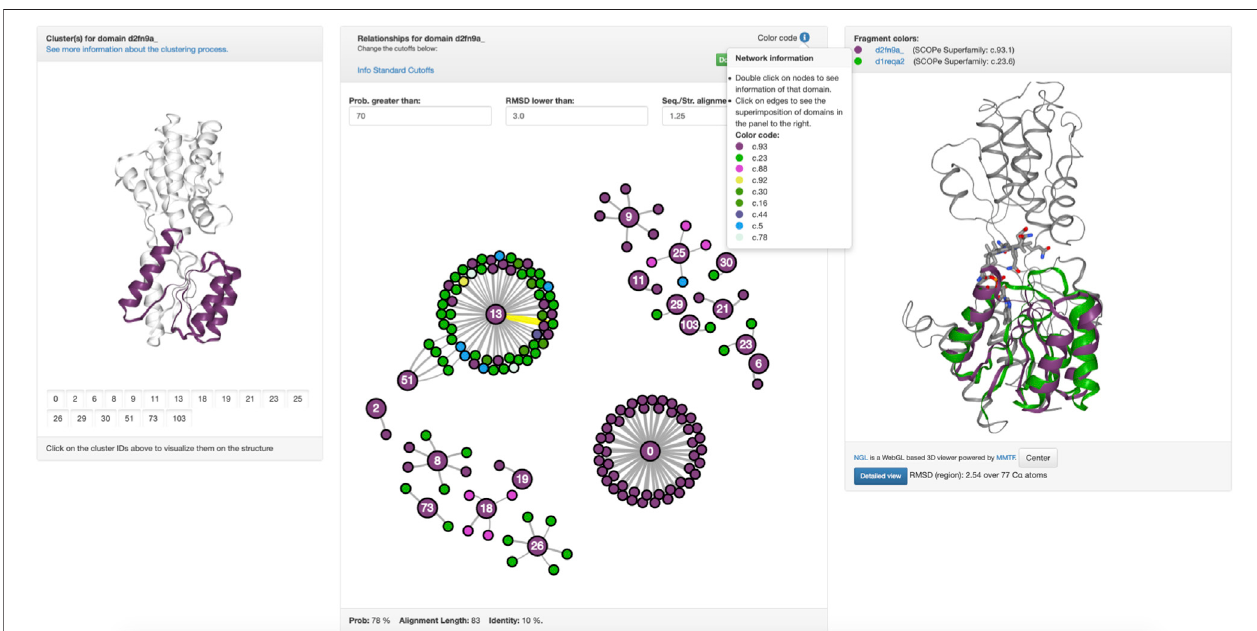
FIGURE 2 | Conservation in tmRBP. (c.f. https://fuzzle.uni-bayreuth.de/2.0/hh/fragment_graph/d2fn9a_/). Left: The panel highlights each hit in d2fn9a_. In this case, cluster 13 has been selected, the main object of this study. Middle: The clusters of d2fn9a_ are shown, where each interactive node is a domain, linked to other domains when they share a fragment. Each ‘ island-like ’ cluster corresponds to a set of proteins that have a fragment in common. Nodes are colored according to their folds (top) . Mousing over an edge it gets highlighted (yellow) and the alignment parameters in the footer are shown (bottom) . An individual PyMOL session of superposedstructuresforeachclustercanbedownloaded (topgreenbutton) . Right: Uponclickingonanedgebetweentwonodes (middlepanel) thesuperposition of the structures with their fragment colored according to their fold will be shown on the